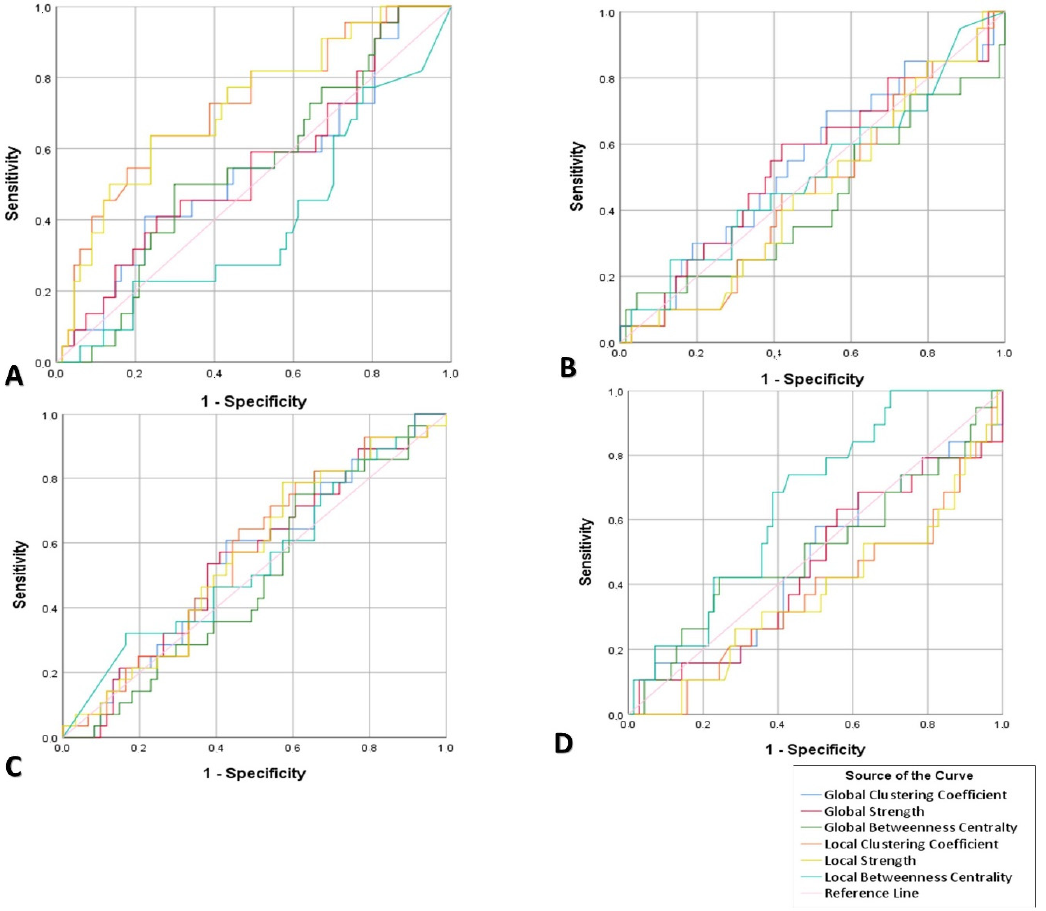
Figure 4. ROC curves presenting for the clustering coefficient, strength and betweenness centrality at local and global levels for discriminating between: ( A ) HC vs. SCD, MCI and AD, ( B ) SCD vs. HC, MCI and AD, ( C ) MCI vs. HC, SCD and AD and ( D ) AD vs. SCD, MCI and HC.